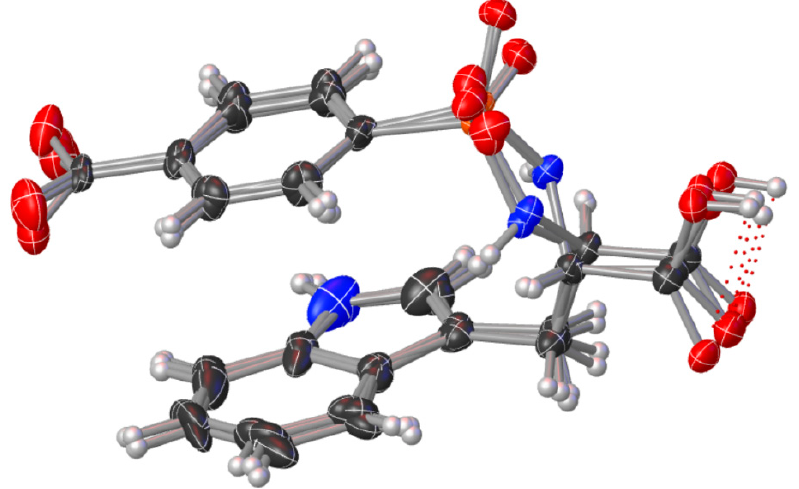
Figure 3. Structure overlay of the four independent DNSPA molecules showing only slight structural differences.